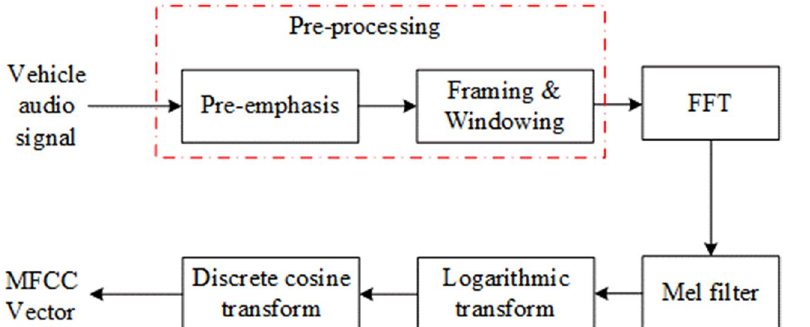
Figure 1. The process of extracting